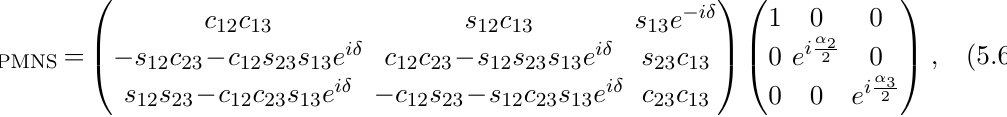
Figure 1 . Histograms of (cid:0)( p and IO cases in blue and green, respectively. The vertical line corresponds to the un(cid:13)ipped SU(5)